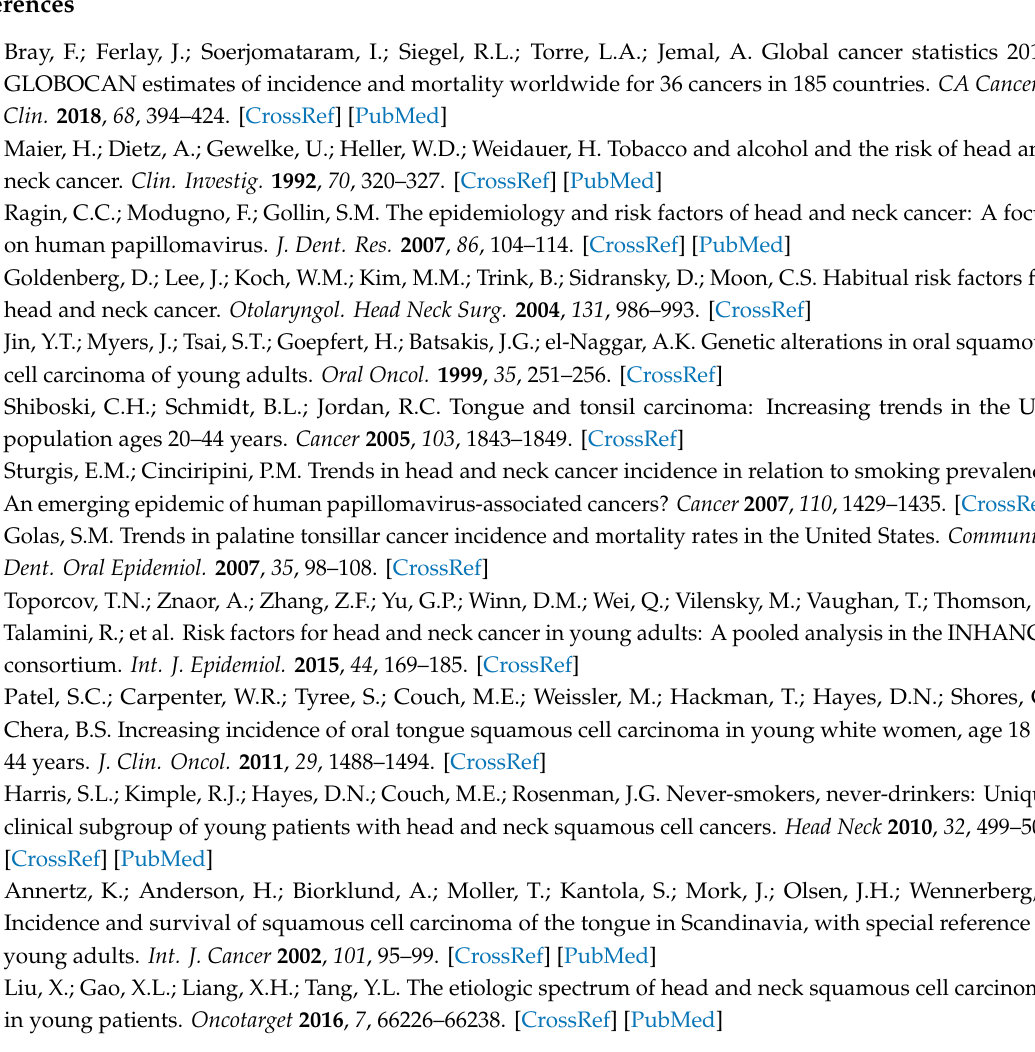
Figure S1: rs6942067 genotype status in the TCGA HNSCC cohort for HPV positive and / or drinking patients ( n = 47) and HPV negative non-drinker patients ( n = 20), Figure S2: Significantly enriched PANTHER pathways in the higher ( n = 50) versus lower ( n = 50) DCBLD1 expressing participants from the HNSCC TCGA cohort, Table S1: Raw data from the TCGA cohort, Table S2: Raw data from the gnomAD